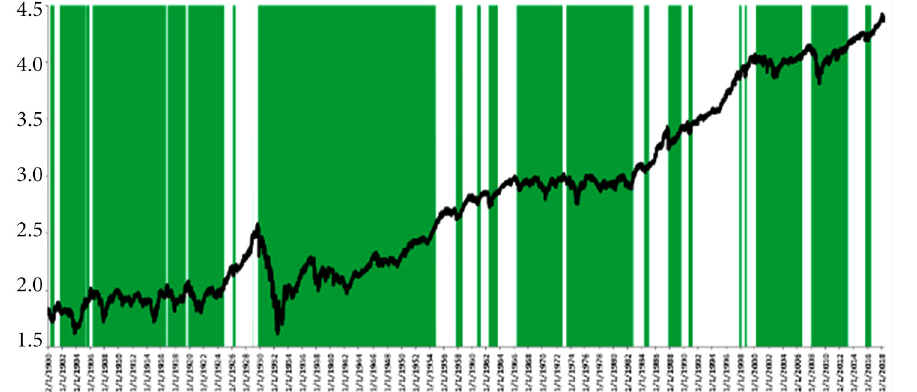
Figure 1. Wrong DJIA entry moment (beginning of green intervals) (source: own processing based on the data available on stooq,